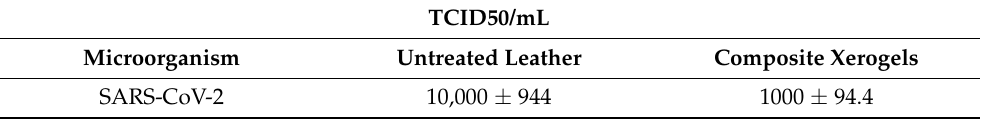
Table 3. Virus viability, as measured using TCID50 on xerogel-coated leather coupons in comparison to the control leather samples. Statistical significance was performed using a t -test.